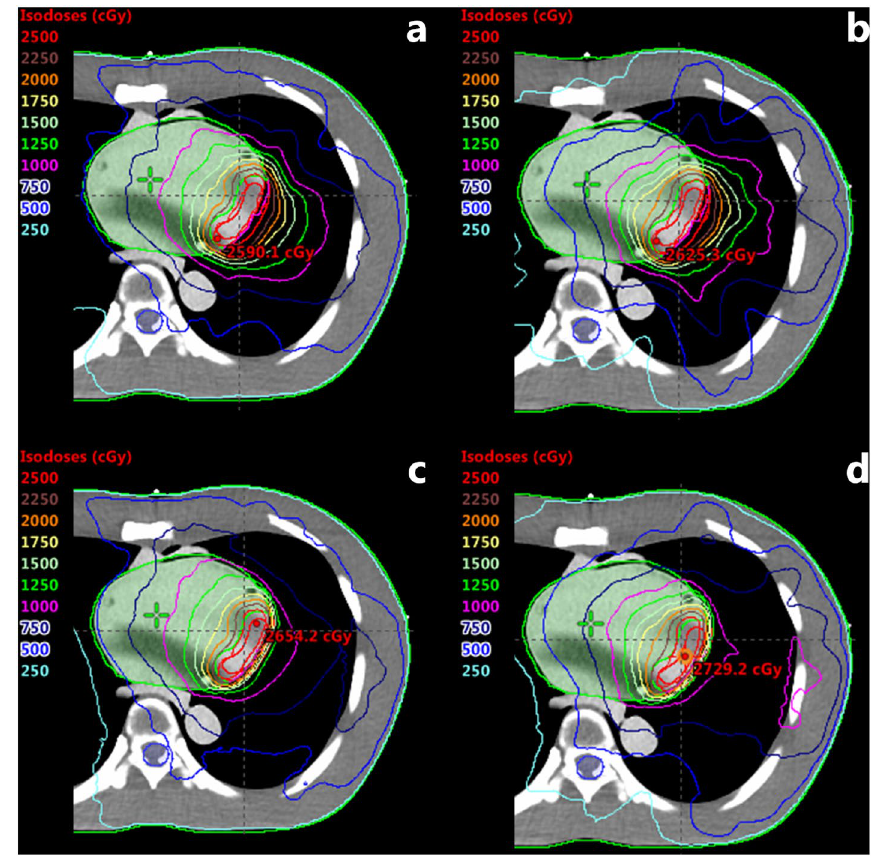
Figure 4. Volumetric modulated arc therapy (VMAT) plans using 6-MV photon beams. ( a ) Full arc treatment (AAA Algorithm), ( b ) half arc treatment (AAA Algorithm), ( c ) full arc treatment (AXB Algorithm), and ( d ) half arc treatment (AXB